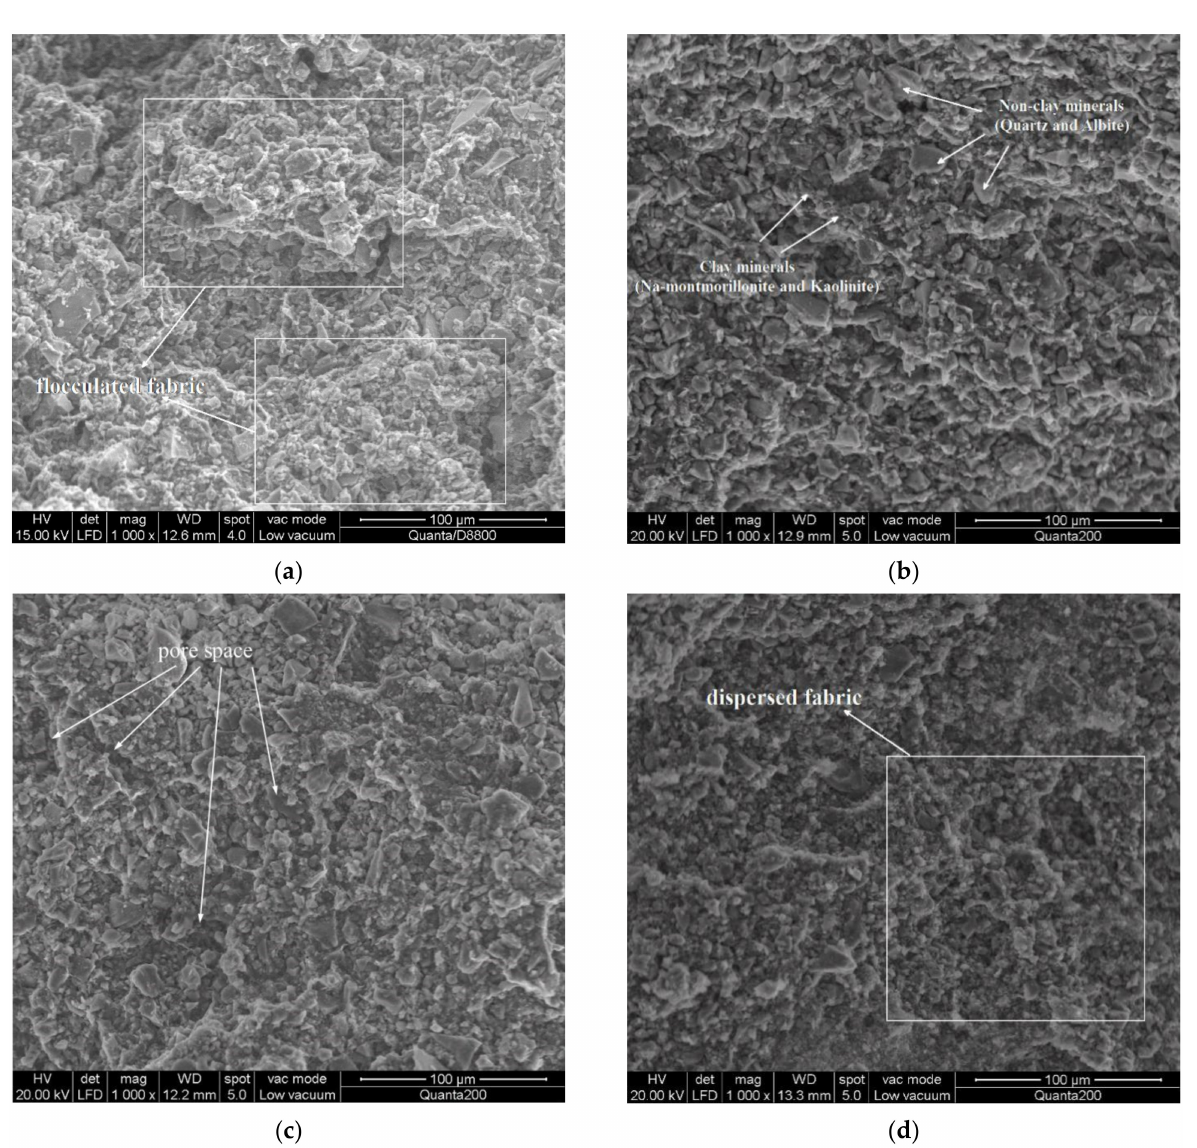
Figure 16. Quanta200 environmental scanning electron microscope (LVESEM) photo of artificial marine clays with a magnification of 1000: ( a ) 8291; ( b ) 8282; ( c ) 8255; ( d )